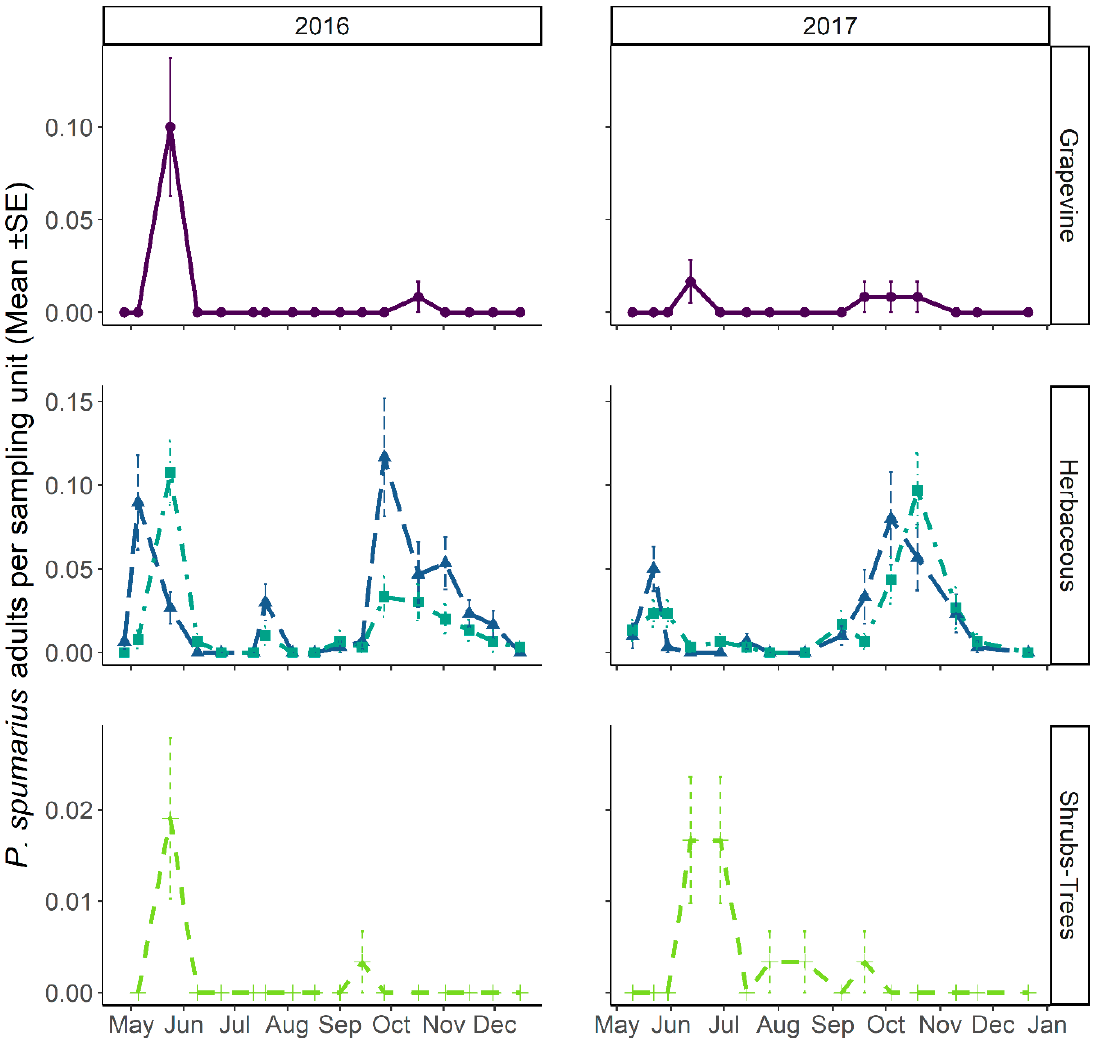
Figure 9. The abundance of Neophilaenus campestris adults on grapevine ( top ), herbaceous cover ( middle ), and shrub–tree ( bottom ) components in the Asti vineyard throughout 2016 ( left ) and 2017 ( right ) sampling periods. In herbaceous vegetation, dashed lines represent headlands and dash-dotted lines represent inter-rows.